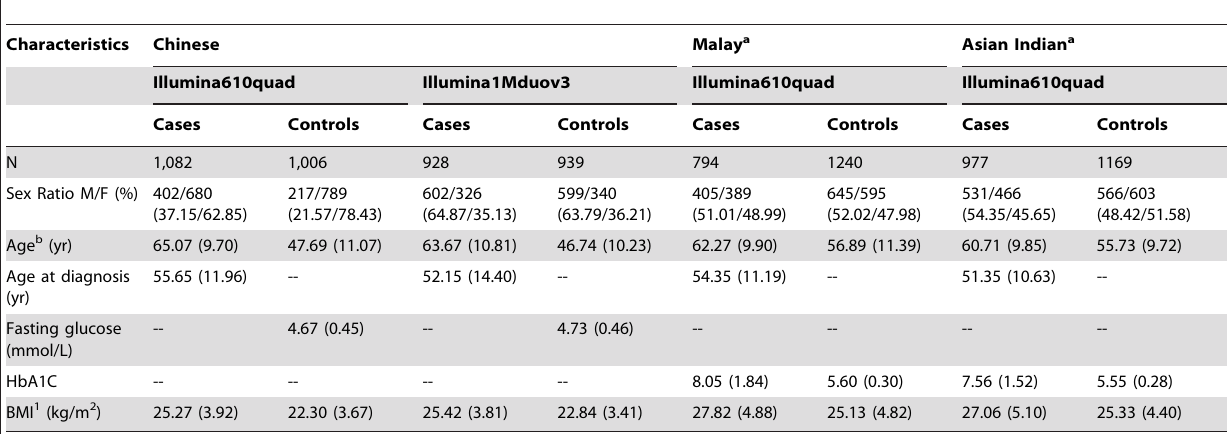
Table 1. Summary characteristics of cases and controls stratified by their ethnic groups and genotyping arrays.